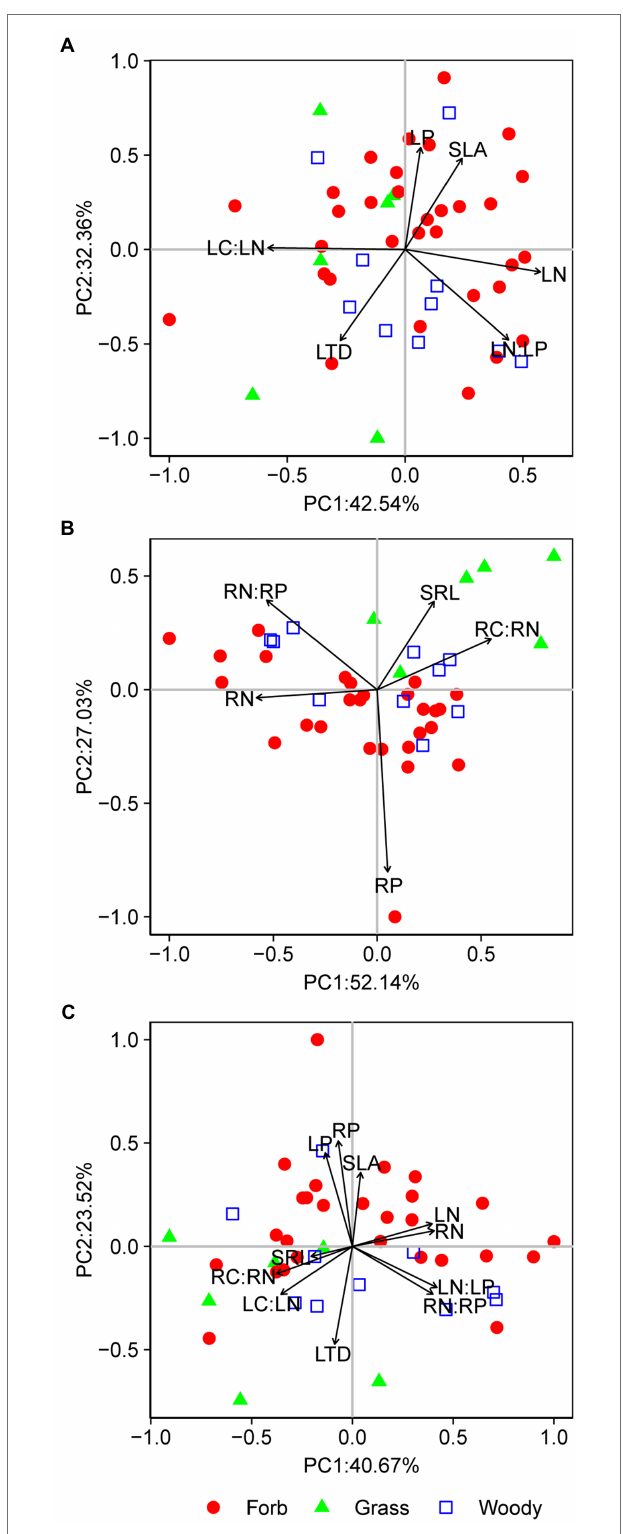
FIGURE 2 | Principal component analyses (PCAs) for leaf traits (A) , fine-root traits (B) , and whole-plant traits (C) . Each data point represents the position of